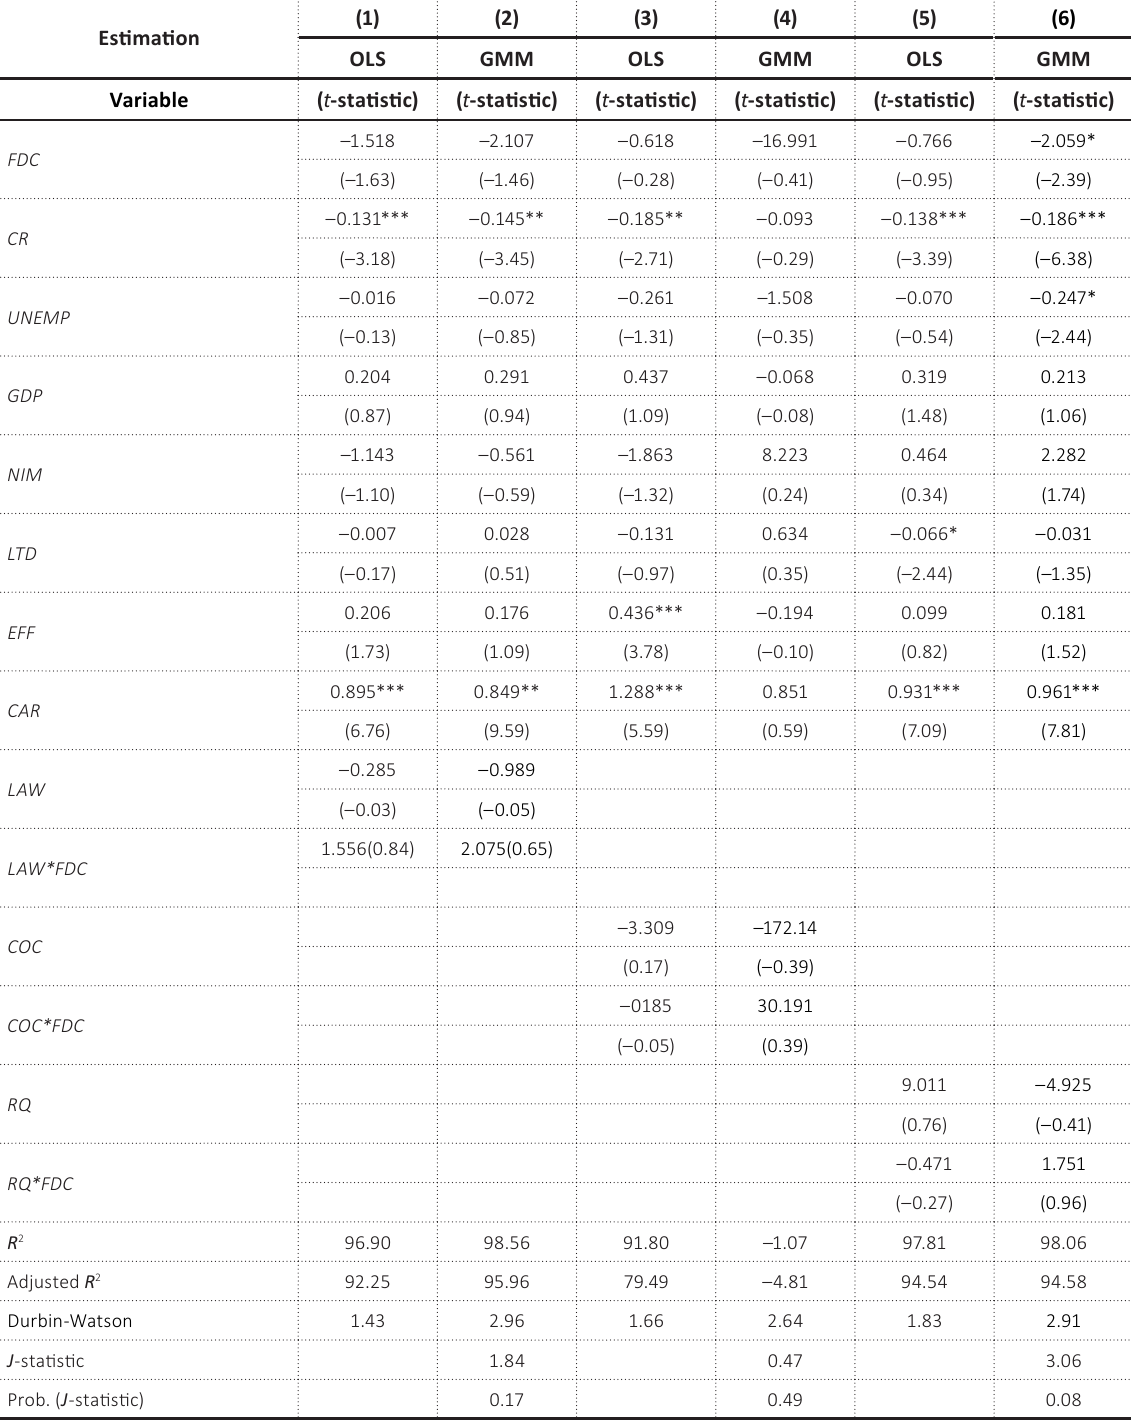
Table 9. Joint-effect of FDI per capita and country governance factors on NPLs